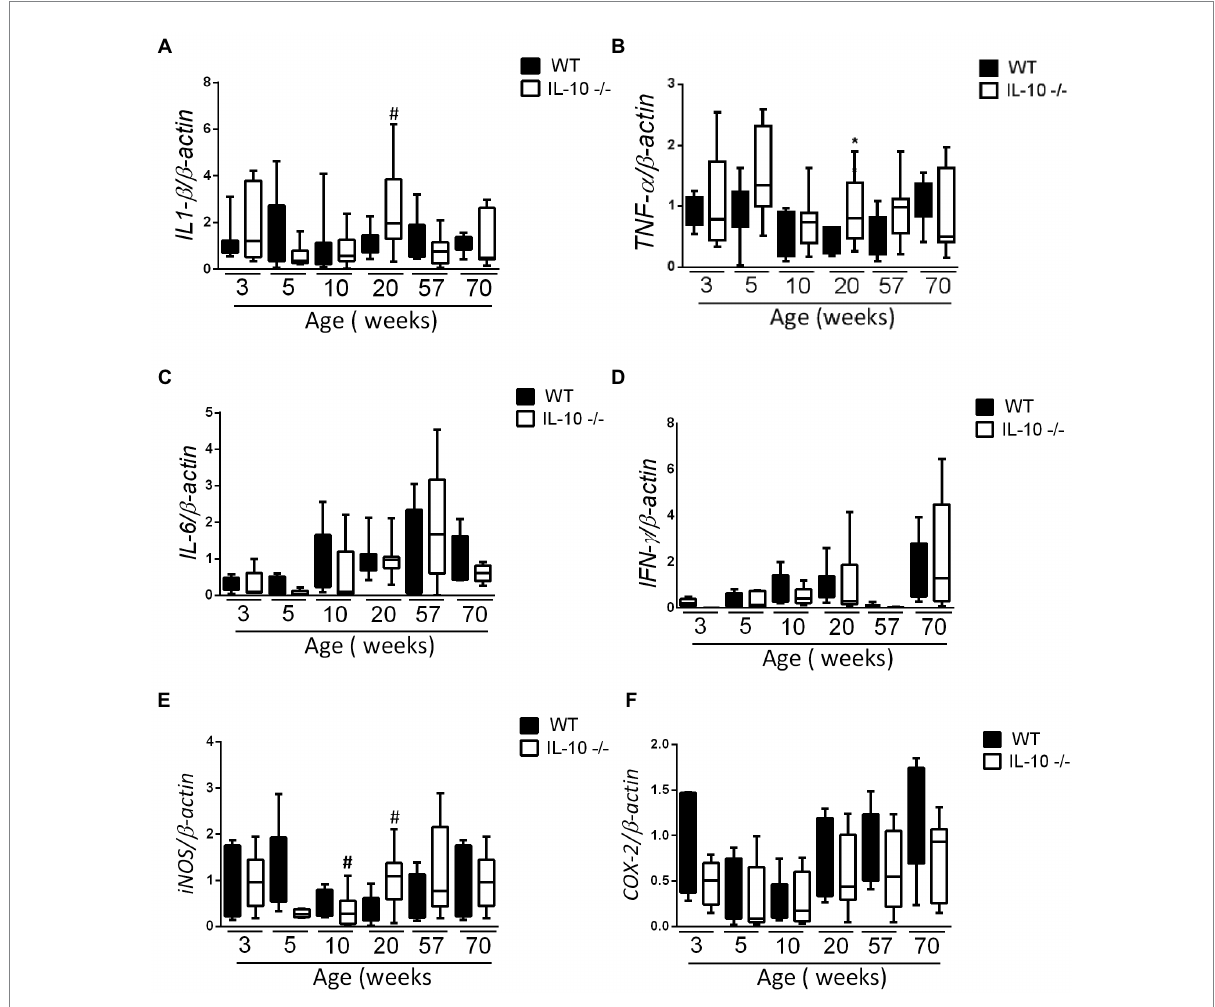
FIGURE 2 Comparison of IL-1 β (A) , TNF- α (B) , IL-6 (C) , IFN- γ (D) , iNOS (E) and COX-2 (F) gene expression WT and IL-10 − / − strains. The normalization was carried out based on the housekeeping gene β -actin and three independent replications were made for each marker studied. C57Bl/6 wild type (WT) group was represented in black and IL-10 deficient mice (IL-10 − / − ) group in white. # p < 0.05 with respect to WT of the same